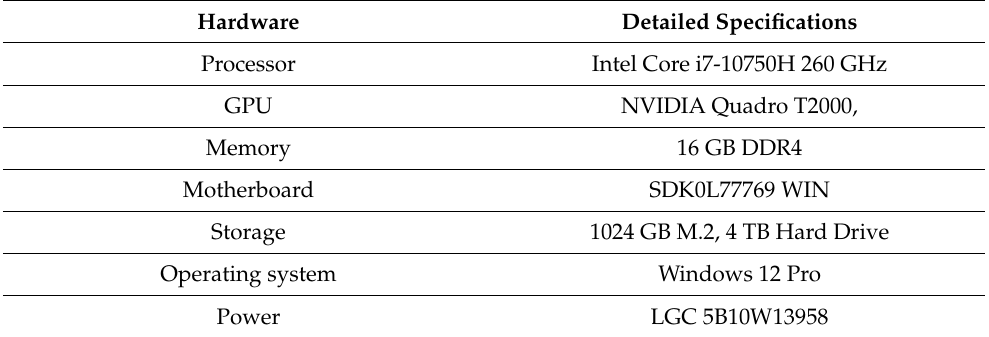
Table 4. Windows desktop specifications used for the